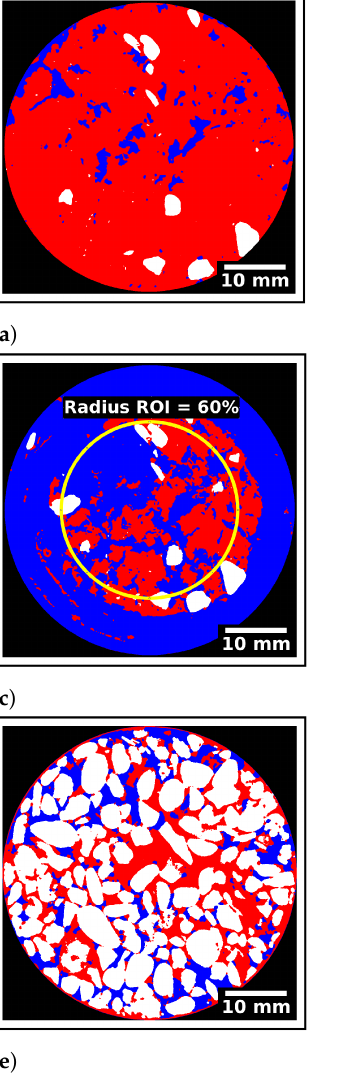
Figure 3. Horizontal slices in the deposit layer ( a – c ) and in the gravel layer ( d – f ) for MON1